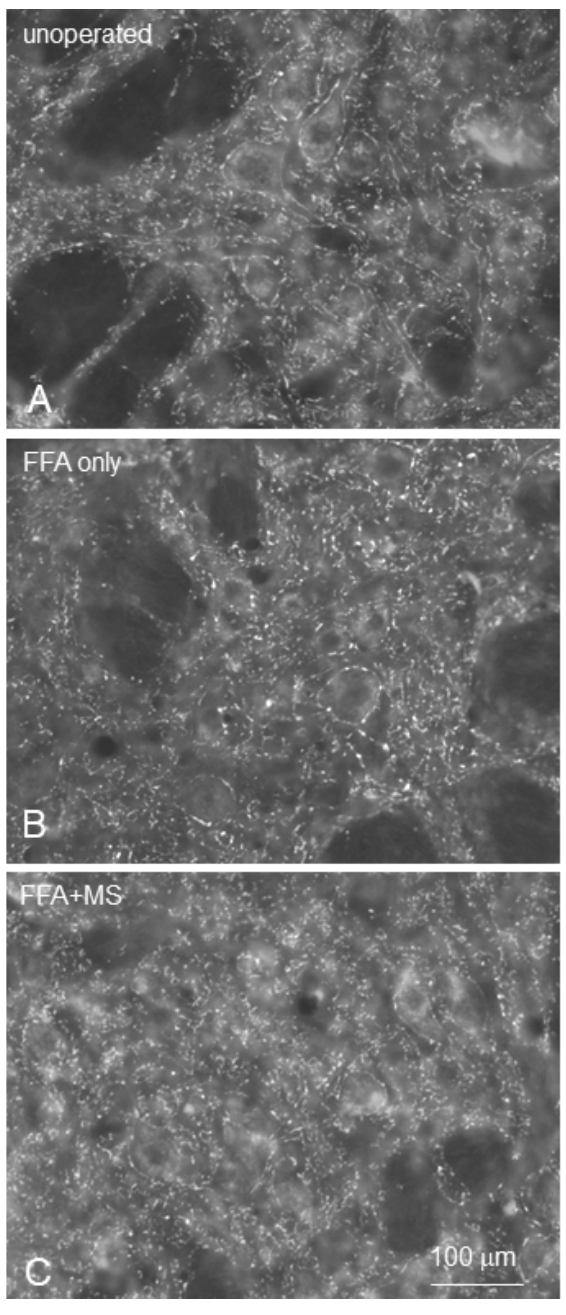
Figure 9. Immunostaining for synaptophysin in 30-µm thick vibratome sections from the facial nucleus in intact rats ( A ), in rats 2 months after Fn-n and handling (Fn-n + handling; ( B )) and in rats that received Mstim of the vibrissal muscles after Fn-n (Fn-n + Mstim; ( C )). Note the clearly discernible numerous puncta within the neuropil and around motoneuronal cell bodies in the facial nucleus representing synaptic terminals. From Pavlov et al. (2008) [41].